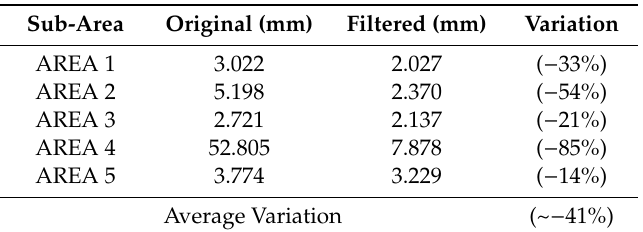
Figure 7. Selected areas for the plane fitting evaluation ( a —Table 6) and for the cloud-to-cloud distance analysis ( b —Table 7). Table 6. RMSEs (Root Mean Square Errors) of plane fitting on five sub-areas for the dense point clouds derived from the original and filtered